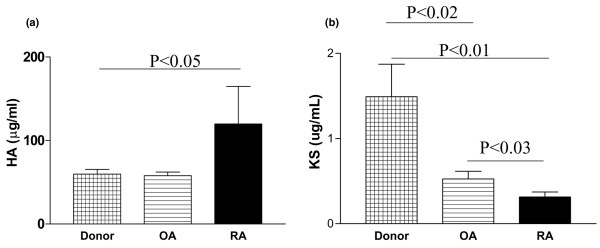
Concentration of hyaluronan and antigenic keratan sulfate in synovial fluid samples. The levels of (a) the hyaluronan (HA) concentration and (b) the antigenic keratan sulfate (KS) in synovial fluid from asymptomatic donors (donor) and from osteoarthritis (OA) and rheumatoid arthritis (RA) patients detected by an ELISA ([21] and [20], respectively). The data are presented as the mean ± standard error of the mean.